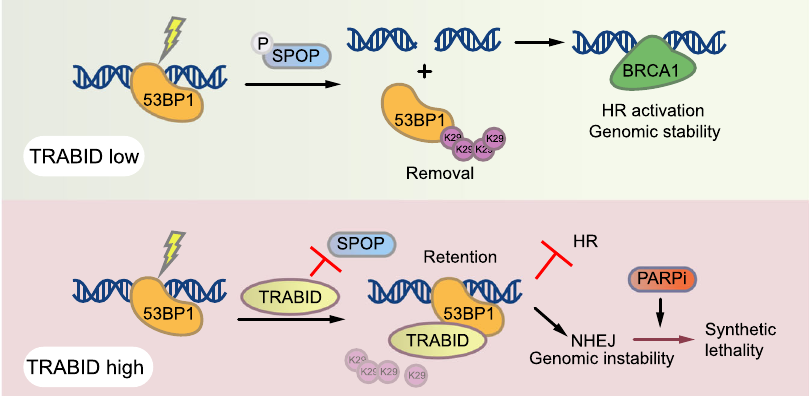
Fig. 7 | Working model illustrating how TRABID regulates genome stability by promoting 53BP1 retention at DSB sites and selection of HR over NHEJ and enabling synthetic lethality to PARP inhibition. Under normal conditions, TRABID expression is low and SPOP is responsible for the removal of 53BP1 from DSB sites, thereby promoting HR over NHEJ. However, prostate cancer-associated